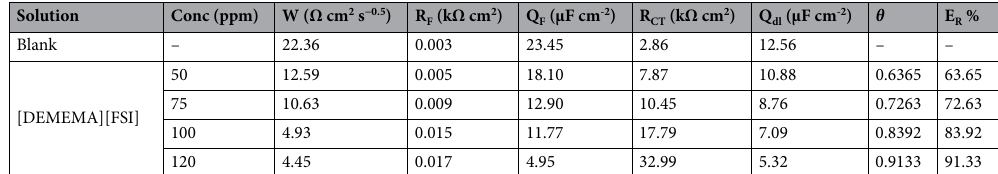
Table 2. EIS parameters and corresponding inhibition efficiency for Cu–Ni alloy in (3.5% NaCl + 10 ppm sulfide) solution in the absence and presence of [DEMEMA][FSI] at 298 K.